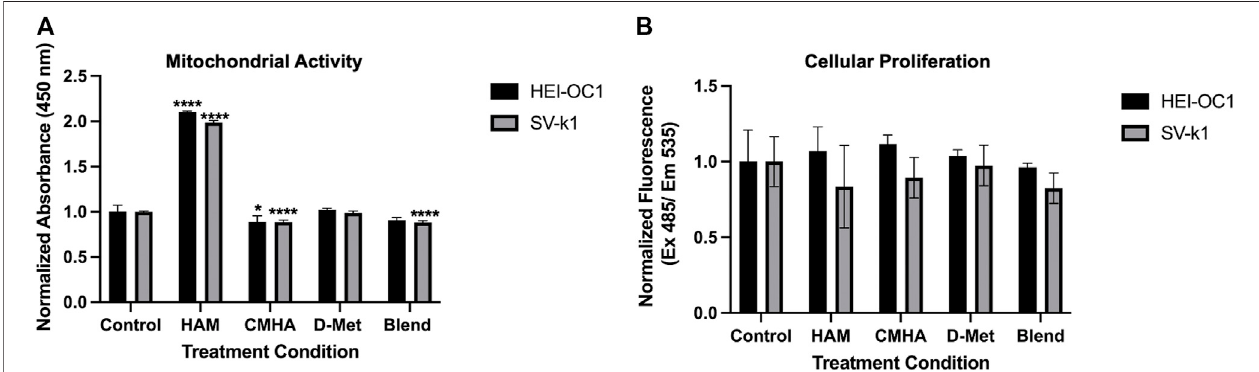
FIGURE 2 | Cytocompatibility of the HAM conjugate. (A) MTS assay data indicating that when HAM is added to cells it impacts the activity of mitochondrial enzymes. Datapresented aremean ±SD. One-wayANOVA with Tukey ’ s multiplecomparisons run foreach cell type individually.HEI-OC1 ANOVAresultscomparedto the control: HAM p < 0.0001 forsigni fi cantincrease,CMHA p = 0.0305, D-Met p = 0.9607, and blend p = 0.0623. SV-k1 ANOVA results compared to thecontrol: HAM p < 0.0001forsigni fi cantincrease,CMHA p < 0.0001forsigni fi cantdecrease,D-Met p =0.9586,andblend p < 0.0001forsigni fi cantdecrease.**** p < 0.0001,* p < 0.05. (B) CyQuant Cellular Proliferation assay data indicating that HAM addition to the cells does not induce cell proliferation. Data presented are mean ± SD. One-way ANOVA with Tukey ’ s multiple comparisons run for each cell type individually. HEI-OC1 ANOVA results compared to the control: HAM p = 0.9288, CMHA p =